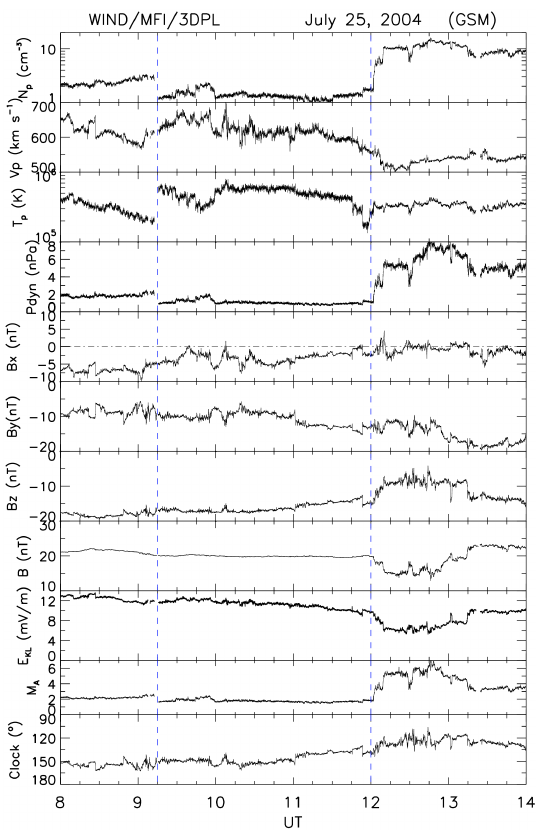
Figure 1. Wind satellite data during the interval 08:00–14:00UT. Panels from top to bottom show proton density ( N p ; cm − 3 ), bulk speed ( V p ; kms − 1 ), proton temperature T p (K), dynamic pressure (nPa), magnetic field components B x , B y , and B z (nT) in GSM coordinates, the total field strength ( B ), the Kan–Lee merging elec- tric field, E KL (mVm − 1 ), the Alfvén–Mach number ( Ma ), and the clock angle of the magnetic field (polar angle in GSM y – z plane). Vertical guidelines mark the drop of P dyn at 09:15UT and subse- quent increase at